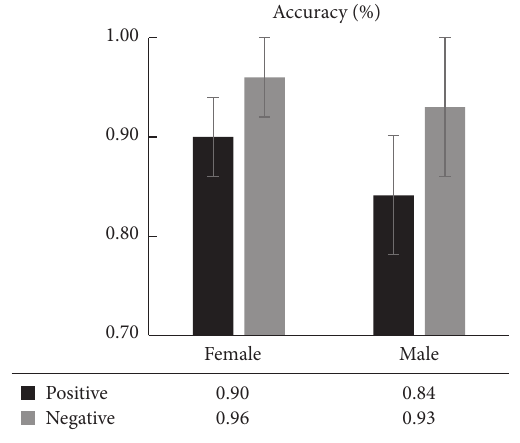
Figure 1: Comparison of the accuracy of the emotional working memory between men and women with